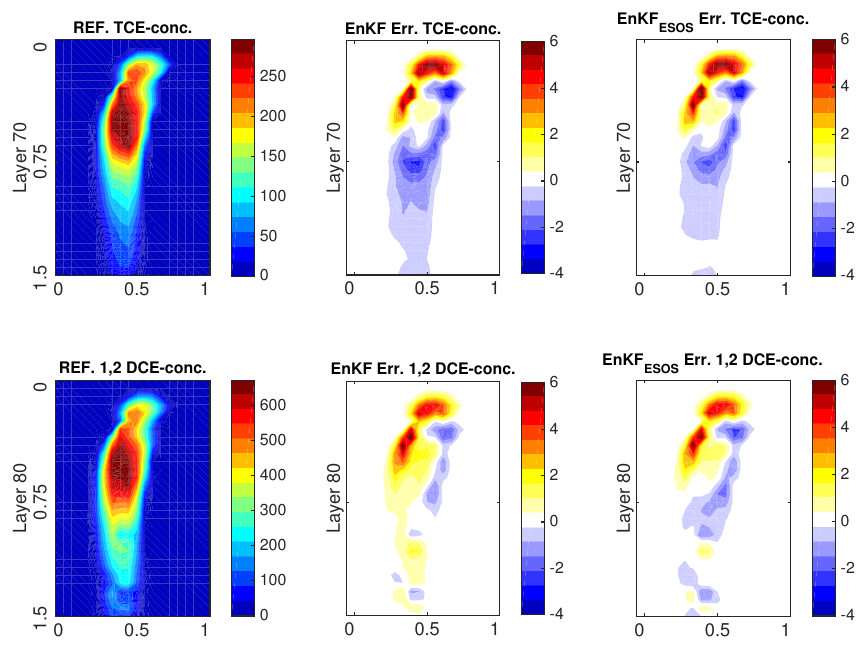
Figure 13. Top panels: TCE concentration and error maps in layer 70 obtained using the reference run (first column), the EnKF (second column) and the EnKF ESOS (third column). Bottom panels: same as top panels but for the concentration of DCE.